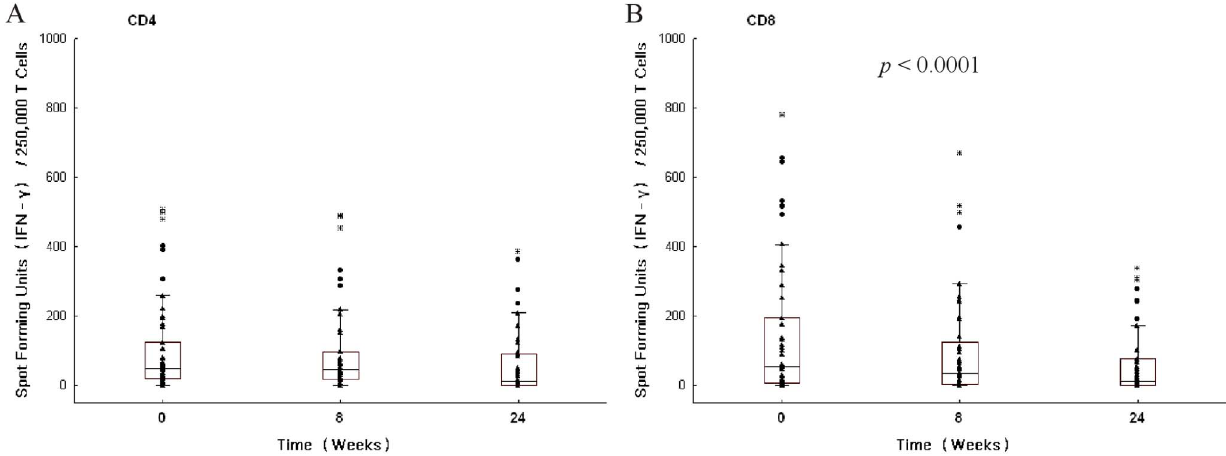
Figure 1. Magnitude of Mycobacteriumtuberculosis (Mtb) specific T cell responses in smear and culture positive, HIV negative, pulmonary TB patients over time during antituberculosis therapy. The magnitude of the Mtb specific CD4 + T cell response (A) and Mtb specific CD8 + T cell response (B) is shown by IFN- c ELISPOT in response to ESAT-6 and CFP-10 and reported in spot forming units per 250,000 T cells. Evaluable samples (n) analyzed per time point were 49, 48 and 42 for baseline, week 8 and week 24 respectively. A negative binomial mixed model was used to assess the overall change during 24 weeks. Raw data, surrounded by the box demonstrates the distribution of 25–75% of the data, with the whiskers representing the non-outlier data, and the horizontal line depicting the median. Raw data is shown with a triangle, outliers with a circle, and extremes with a star.